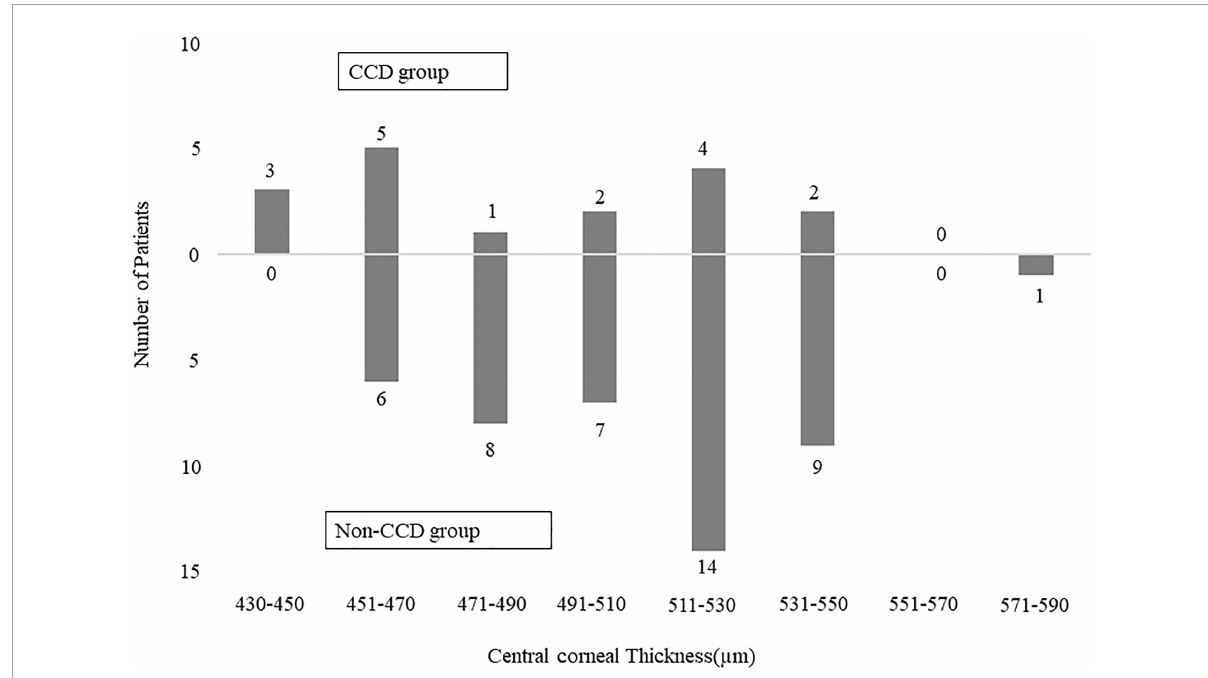
FIGURE3 Bar graph showing the number of patients of CCD group and non-CCD group in each central corneal thickness.